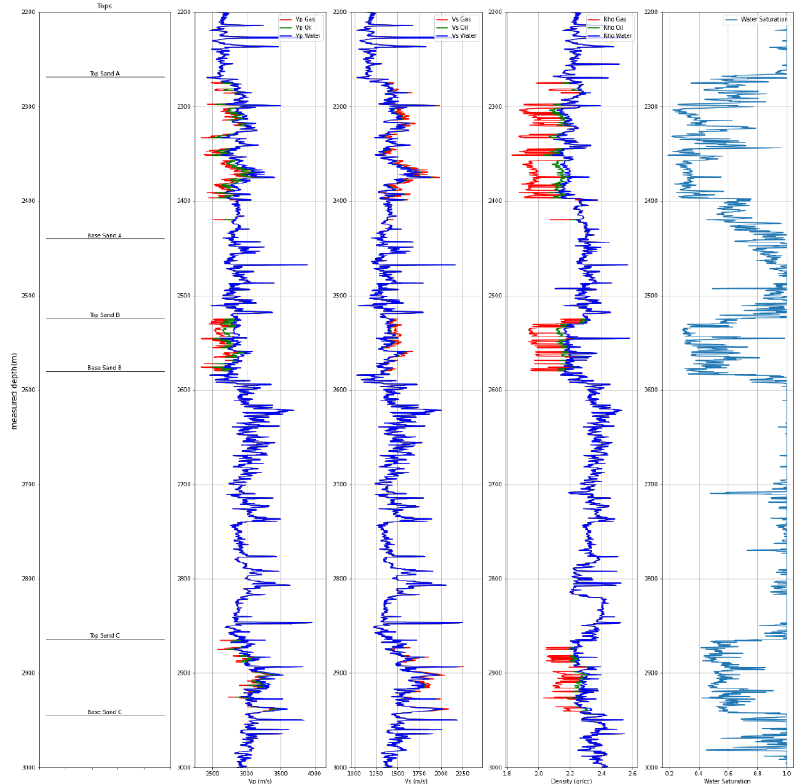
Figure 2. Fluid replacement modelling result on synthetic wells.